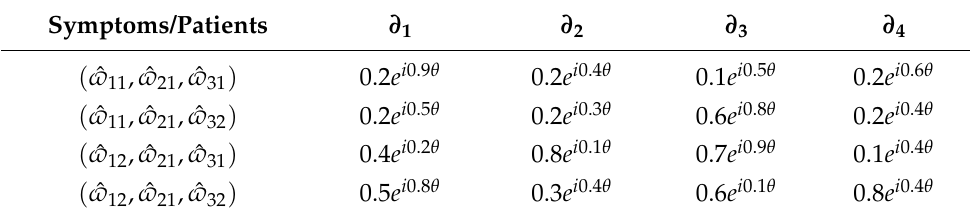
Table 5. z 2 F : Symptoms from F on the second day of patient’s treatment.